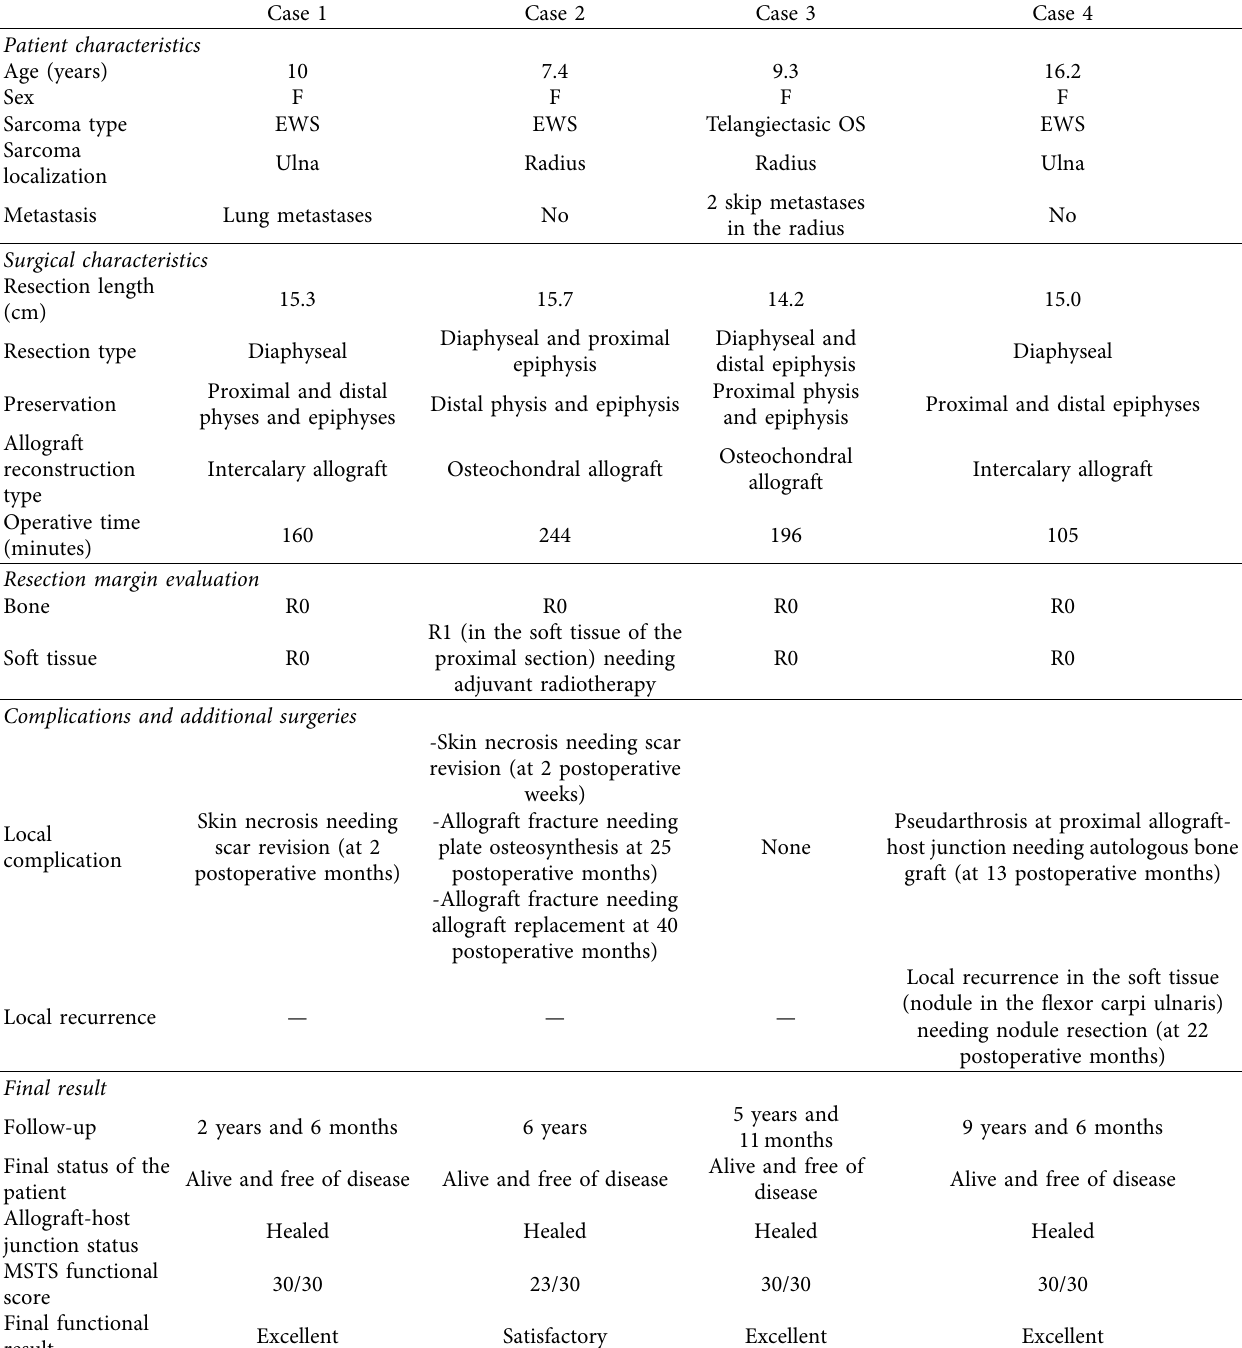
Table 1: Details of the 4